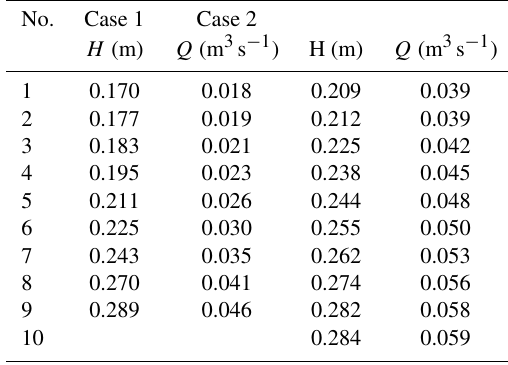
Table A1. Measured water depth H and flow rate Q for quasi- uniform flow conditions in flume experiments with a constant slope s = 5 × 10 − 4 (Koziol, 2010; Kozioł, 2013; Kozioł and Kubrak, 2015).